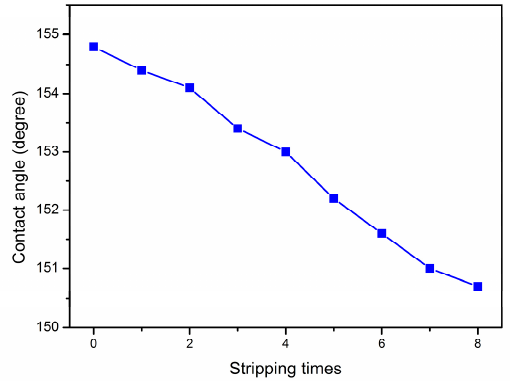
Figure 11. Relationship between the water CA of TiO-HBP/PU-6 nanocomposite coating and the number of stripping tests.